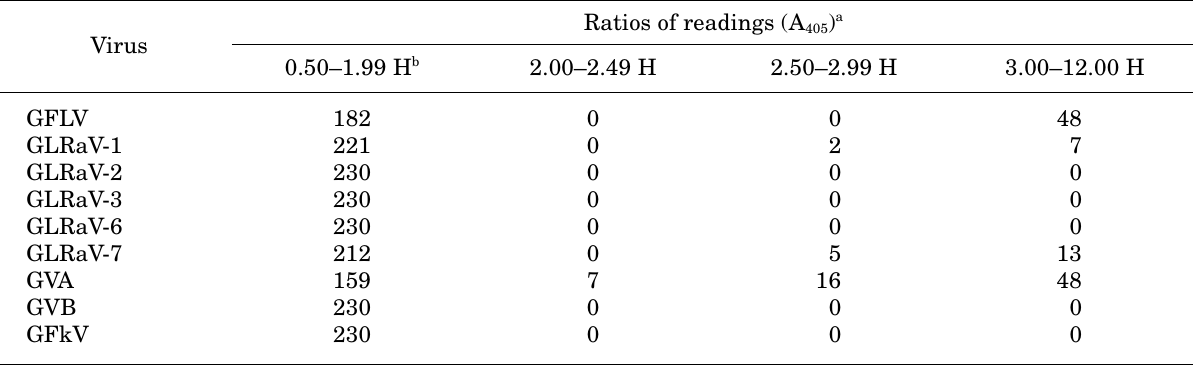
Table 1. Serological (ELISA) detection of grapevine viruses in 230 vines of local cultivars from Paros. (Values in the Table are expressed as number of vines showing a positive reaction [ratios of reading higher than 2.50 at A